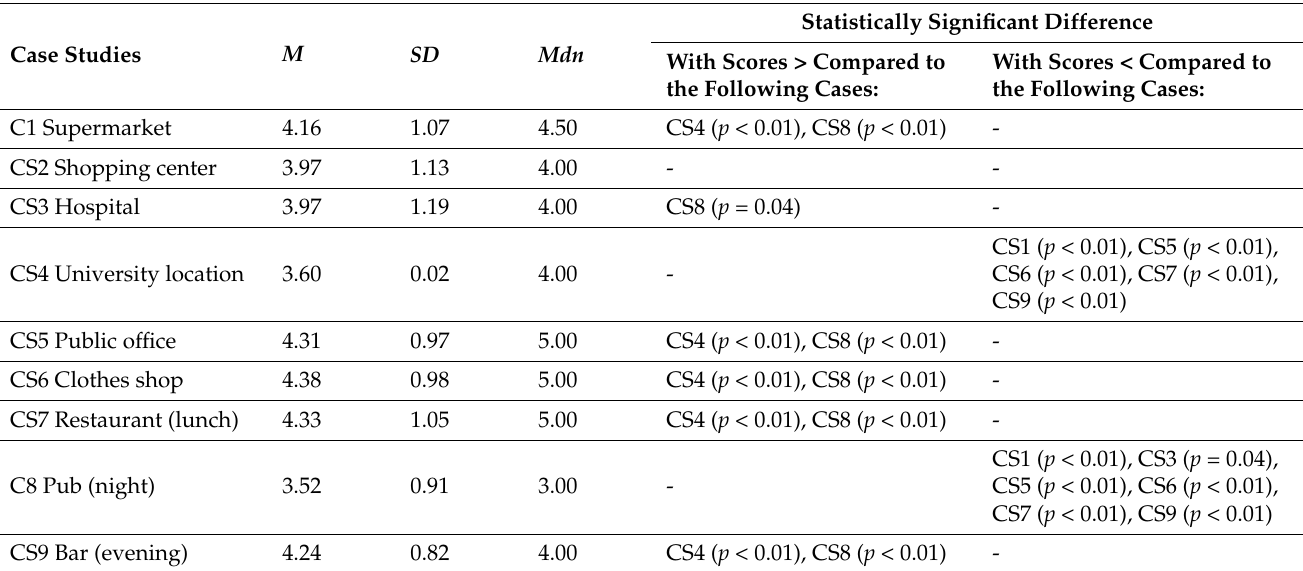
Table A22. Table shows the statistically significant differences ( p (BH)) that emerged from the comparison of item 20 in the different case studies (CS1–CS9). In the table is also reported the mean ( M ), the standard deviation ( SD ) and the median ( Mdn ). Own processing.